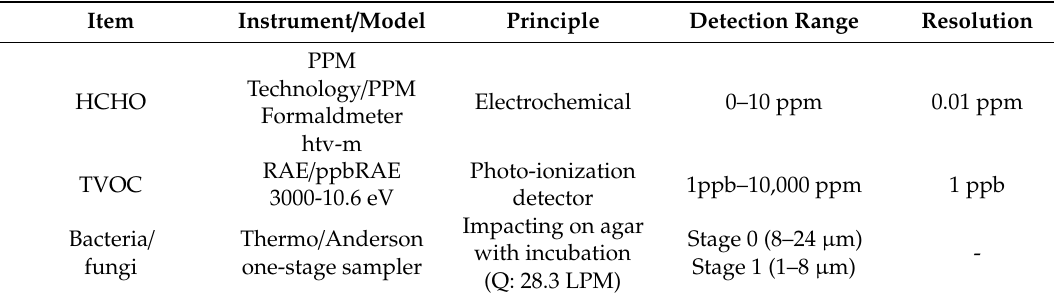
Table 2. Details of instruments for indoor air quality